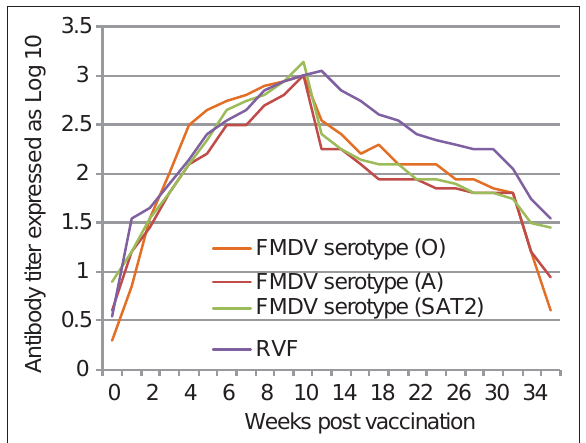
Figure-3: Mean antibody titers in pregnant ewes vaccinated with combined Foot and Mouth disease/Rift Valley Fever vaccine estimated by enzyme-linked immunosorbent